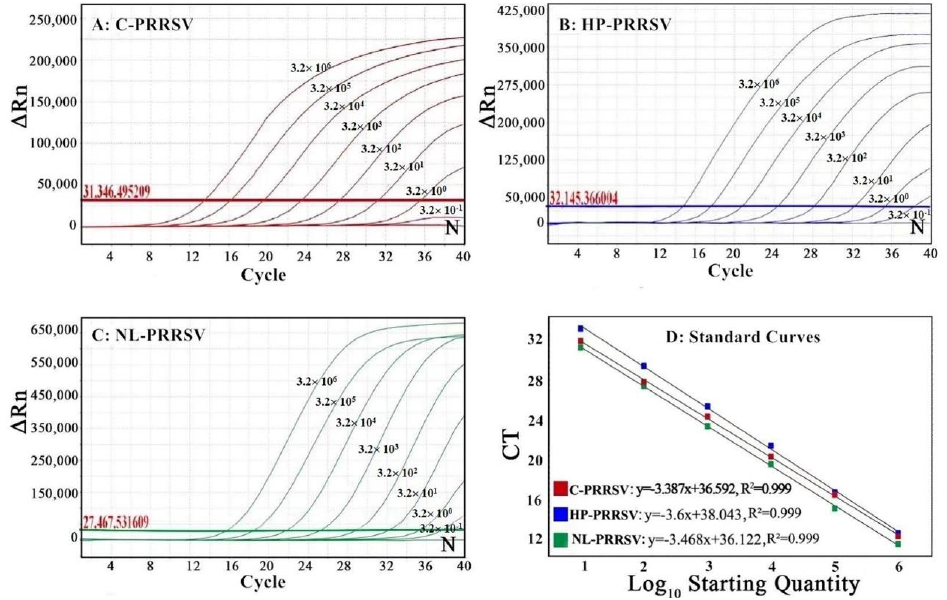
Figure 2. The sensitivity ( A – C ) and standard curves ( D ) of the multiplex qRT-PCR. In ( A – C ), the final concentrations of the plasmids were from 3.20 × 10 6 copies/μL to 3.20 × 10 −1 copies/μL. N: negative control. The red numbers represent the fluorescence values of the threshold baselines.